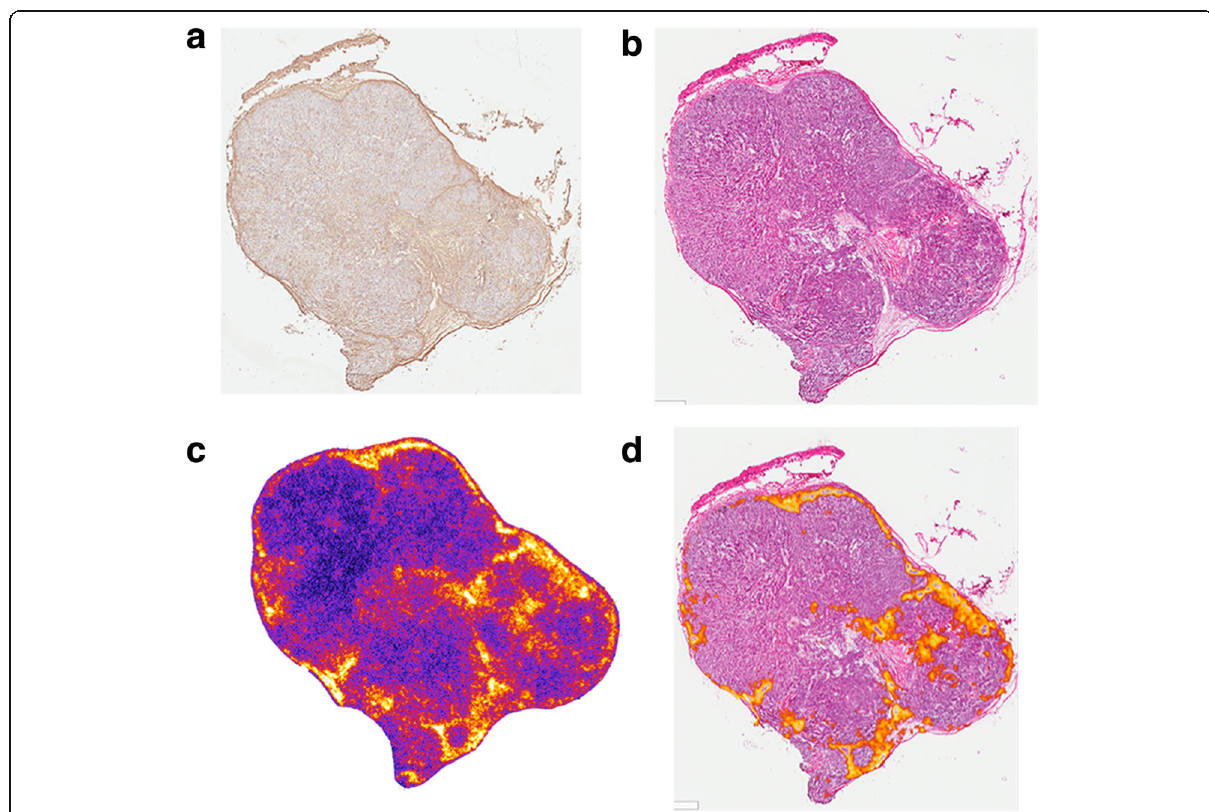
Fig. 9 Four sections of a tumor collected 72 h after 225 Ac-DOTA-anti-PD-L1-BC antibody administration. a CD8 immunohistochemistry and b H&E stain. c Alpha-camera and d segmented high-intensity alpha-camera regions overlayed on the H&E-stained section